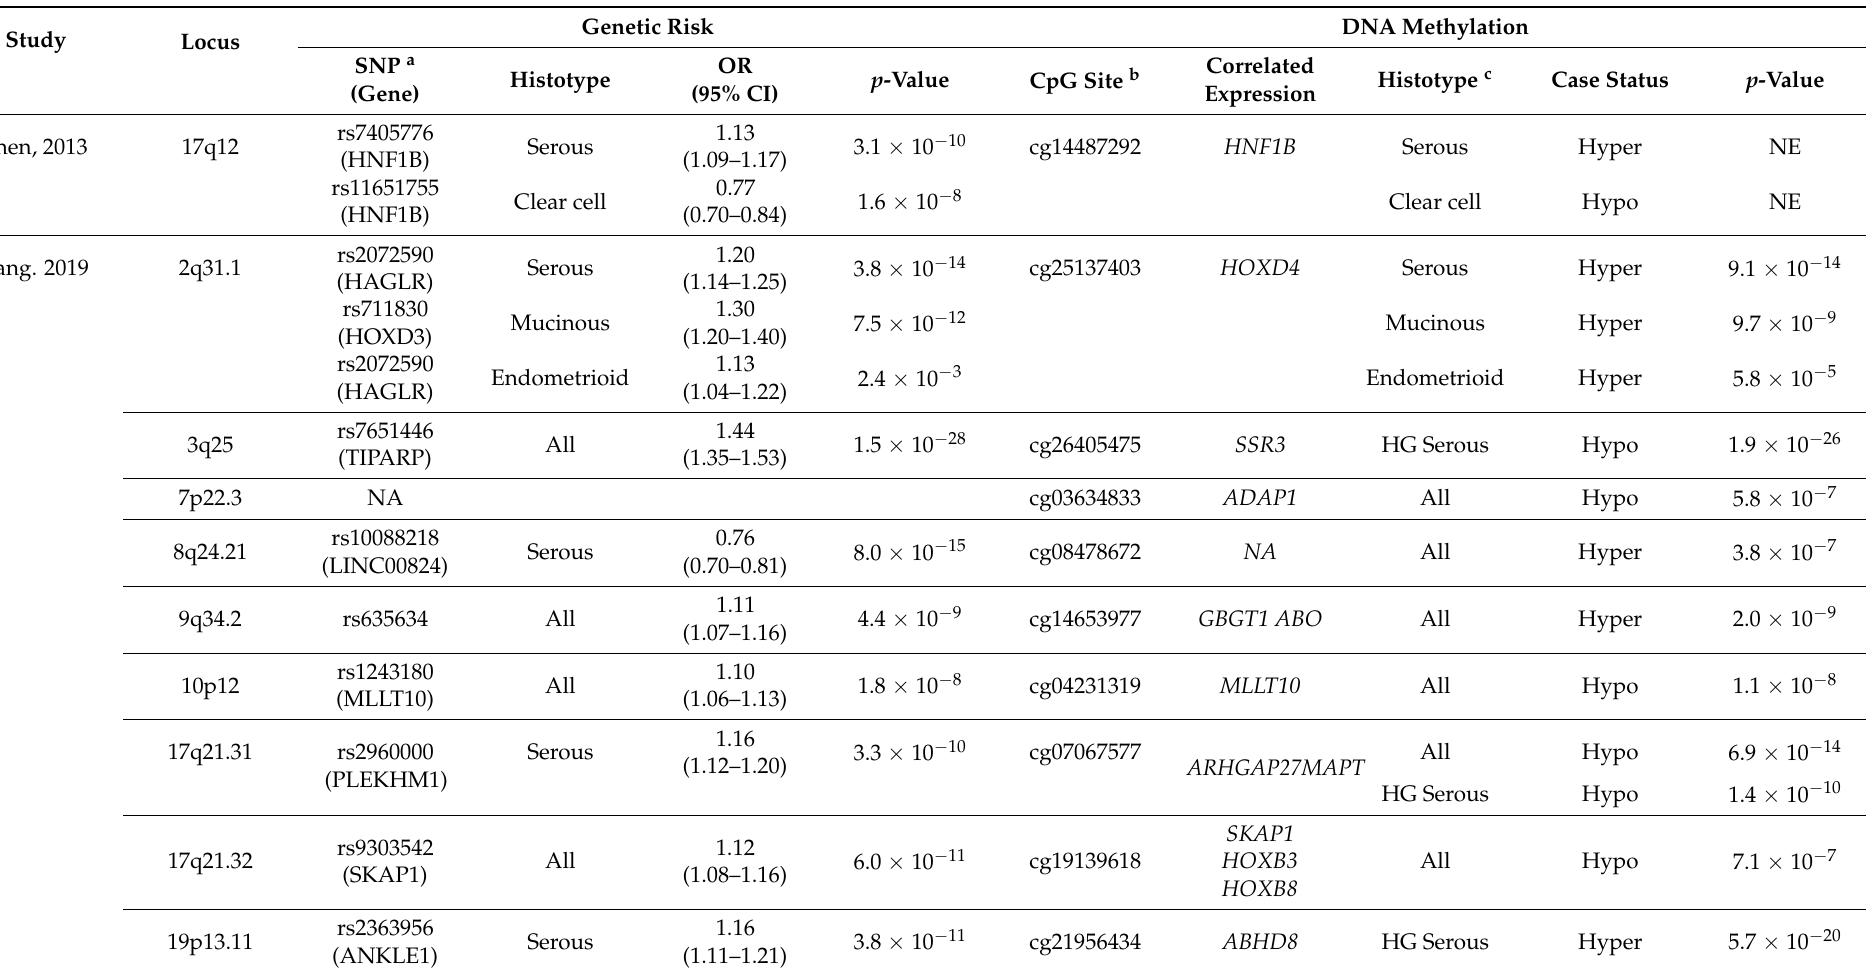
Table 3. DNA methylation associated with genome-wide significant genetic risk